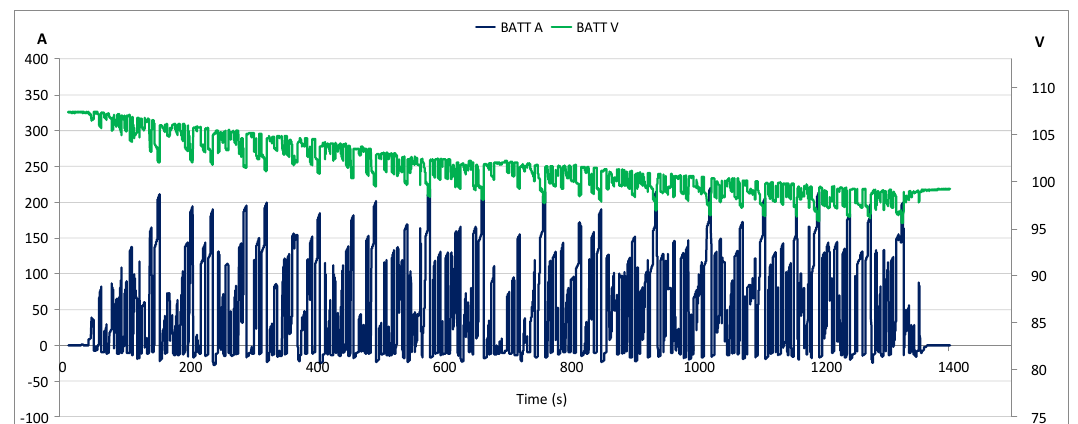
Figure 16. Battery-pack voltage and current during the FK1 test.